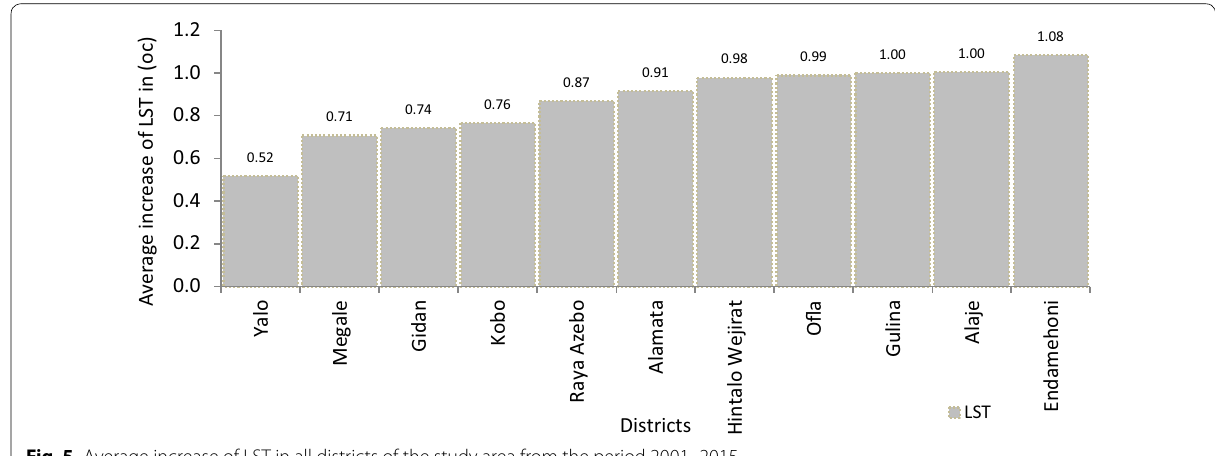
Fig. 5 Average increase of LST in all districts of the study area from the period 2001–2015